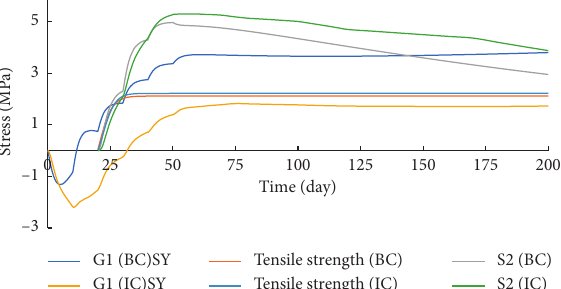
Figure 20: Stress duration curve along the flow direction of G1 and principal stress duration curve of S2 (200